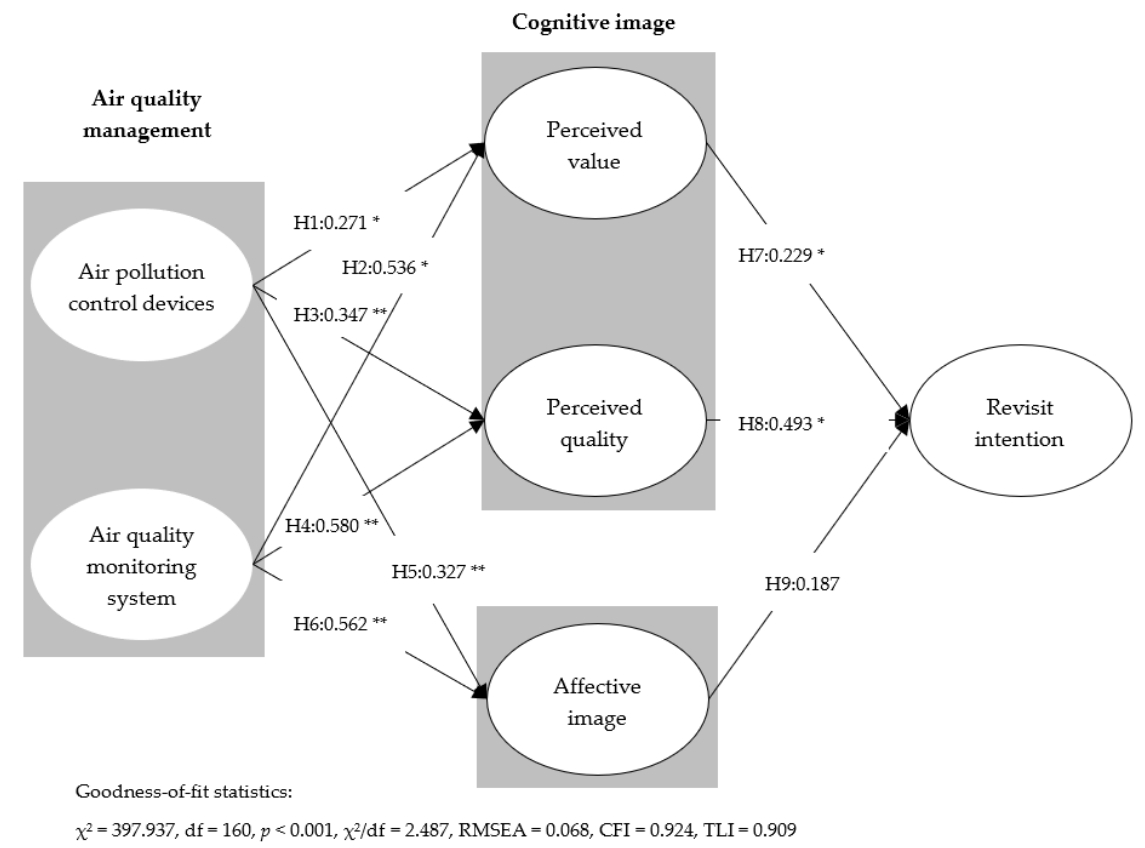
Figure 1. Structural model results and hypotheses testing. * p < 0.05, ** p < 0.01. Note. Goodness-of-fit statistics for the structural model: χ 2 = 397.937, df = 160, p < 0.001, χ 2 / df = 2.487, RMSEA = 0.068, CFI = 0.924, TLI = 0.909. Table 3. The structural model results.